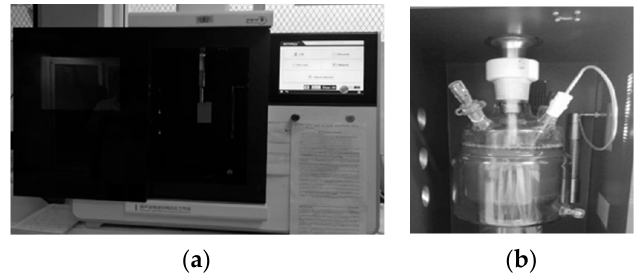
Figure 2. ( a ) Ultrasound/Microwave Cooperative Workstation; ( b ) Reactor for